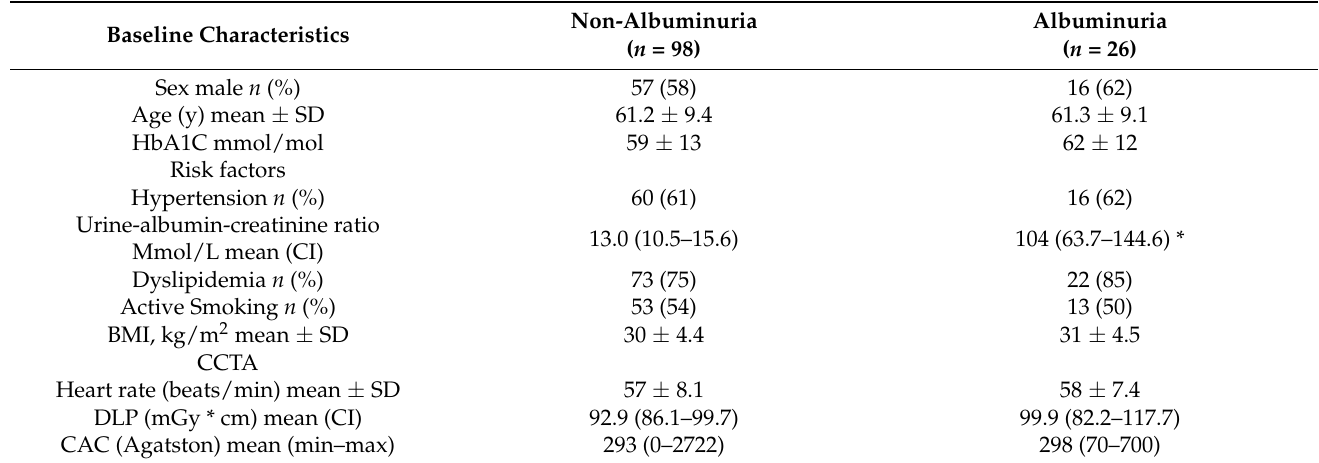
Figure 1. Both groups were primarily male, with 58% in the group with albuminuria being male and 62% in the group without albuminuria being male, respectively. There were no statistically significant differences between groups. Addi- tionally, the risk factor distribution and CCTA parameters were comparable with no significant differences found between the groups. Baseline values are listed in Table 1. Mean CAC score between groups was non-significant, although a broader range was seen in the non-albuminuria group. Table 1. Baseline characteristics of the non-albuminuria and albuminuria T2D groups.